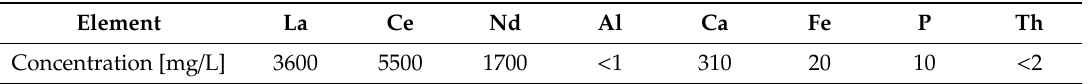
Table 7. Metal ion concentration of a typical leach solution with low impurity content.